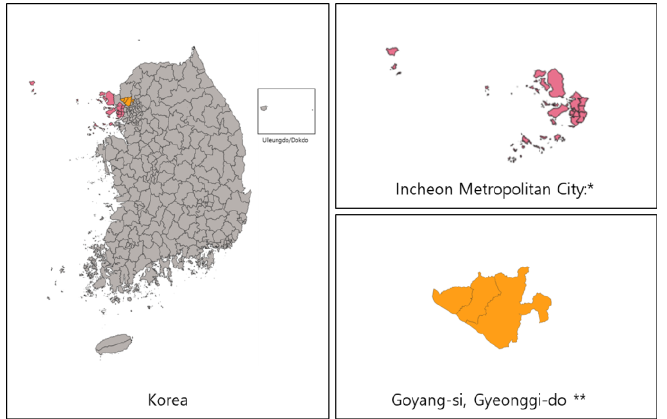
Figure 5. Plan evaluation target site. Notes: * Metropolitan City. ** City (Si) (with urban form and a population of more than 50,000).